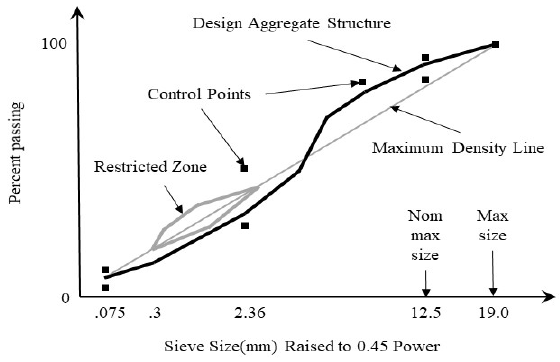
Figure 2. Superpave control points and restricted zone.